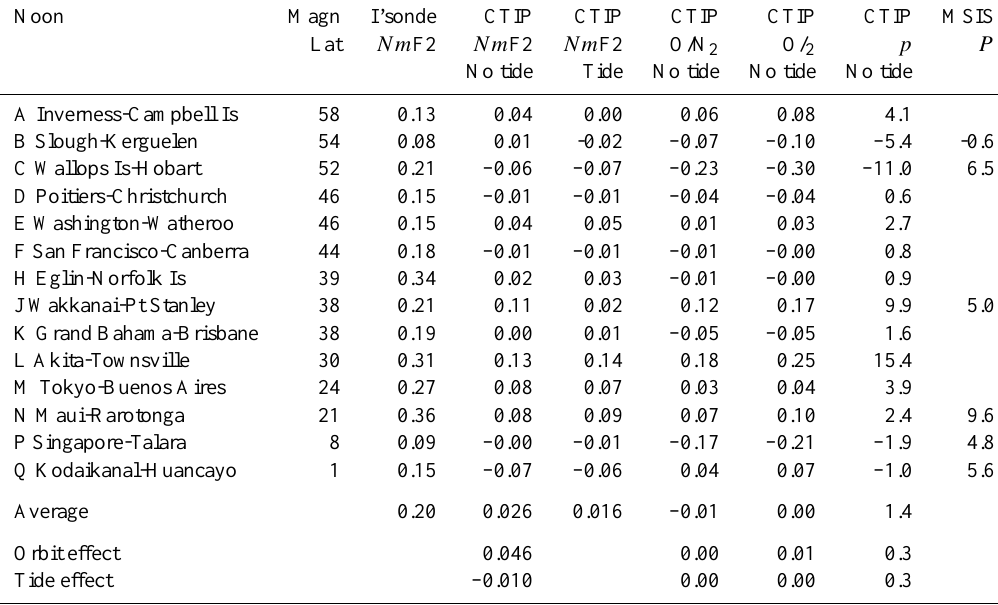
Table 4. Noon annual asymmetry at pairs of stations for moderate solar activity ( F 10 . 7 ∼ 140). Ionosonde values are taken from Table 1 (and are averaged for the three pairs for which Table 1 values are at 100 and 180). CTIP values include varying Sun Earth distance. Neutral composition is computed at a fixed pressure-level. Orbit effect and tide effect as in Table 3. See text for further